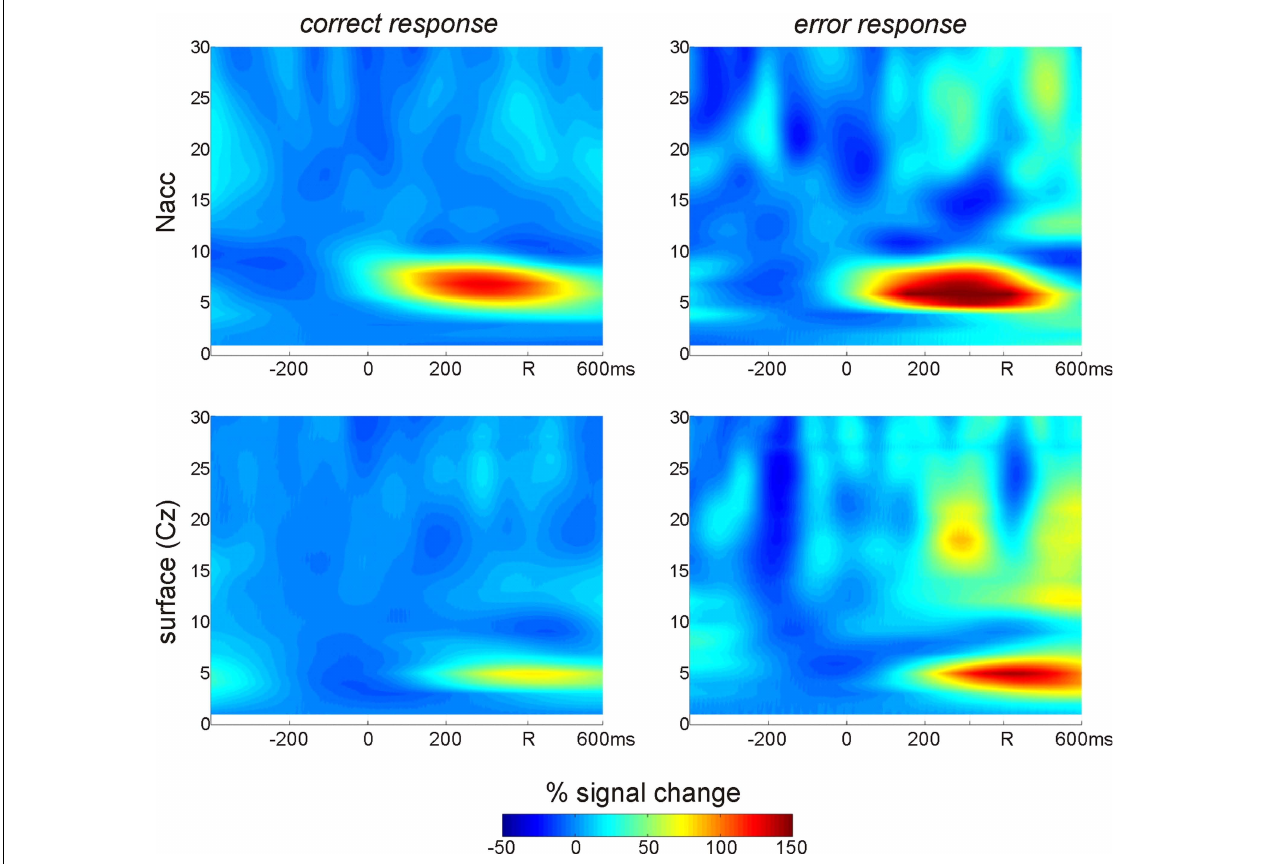
FIGURE 2 | Time frequency analysis of Ncl accumbens LFP and surface activity in patient GM. Two main fi ndings emerge from the wavelet based time-frequency analysis: First, errors are associated with an increased power in the theta range compared to correct trials. Second, theta activity emerges considerably earlier in the depth